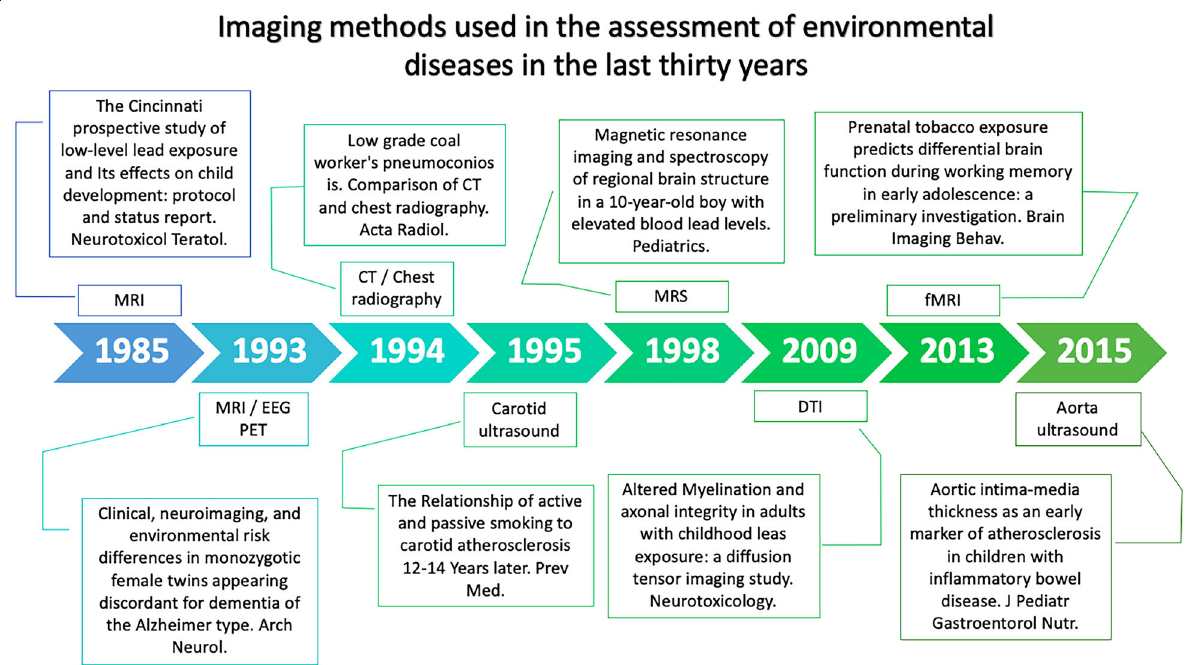
Fig. 2 Timeline representing the evolution of imaging methods in the study of environmental